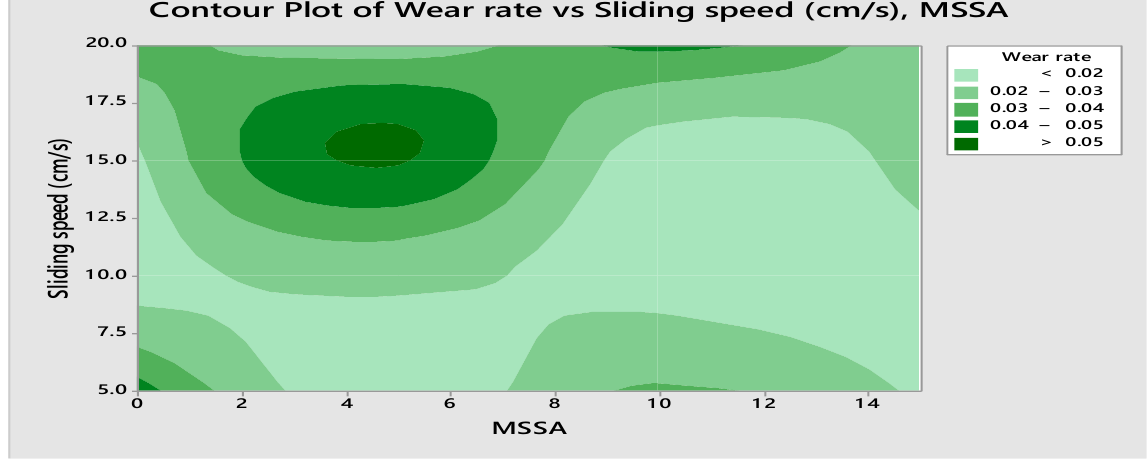
Figure 5: Wear Map 2 shows the lowest wear rate at sliding speed of 10cm/s and 15 wt%